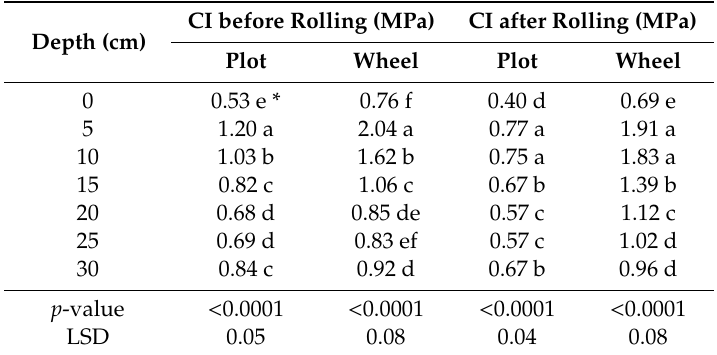
Table 14. Soil cone index (CI) values for di ff erent depths (0–30 cm, with 5 cm increments) averaged over rolling treatments in 2016 growing